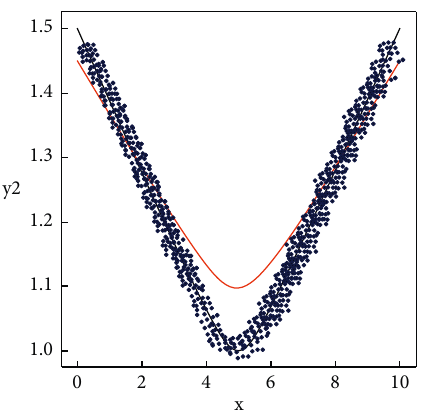
Figure 1: Overall quadratic function.